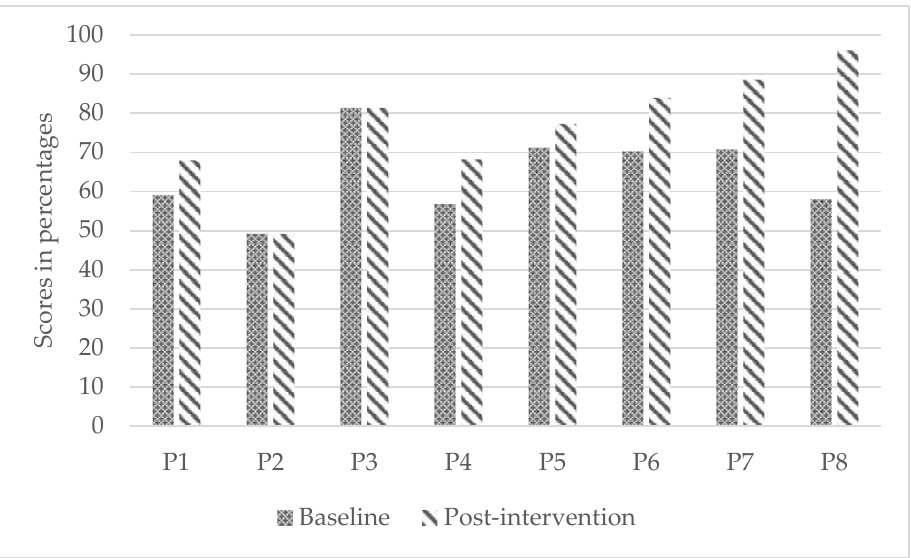
Figure 4. Individual improvements in wheelchair use self-efficacy from baseline to post-interven- tion.